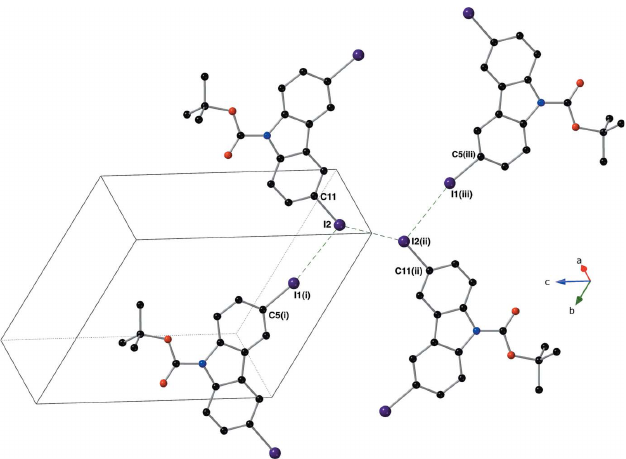
Figure 3 A figure showing the halogen–halogen interactions (depicted as green, dashed lines) present in the crystal of compound I using a ball-and-stick model with standard CPK colors (I = purple). The unit cell is drawn with a solid black line. [Symmetry codes: (i) (cid:4) x + 1, (cid:4) y + 1, (cid:4) z + 2, (ii) (cid:4) x + 2, (cid:4) y , (cid:4) z + 2, (iii) x + 1, y (cid:4) 1, z .]